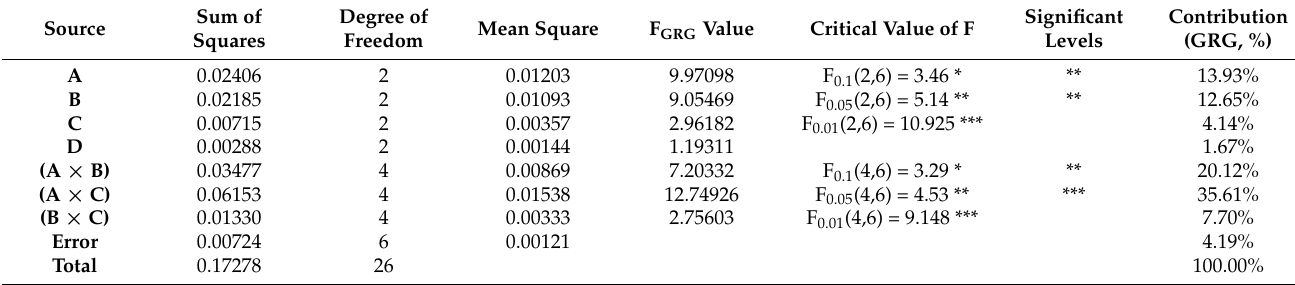
Table 13. ANOVA analysis for